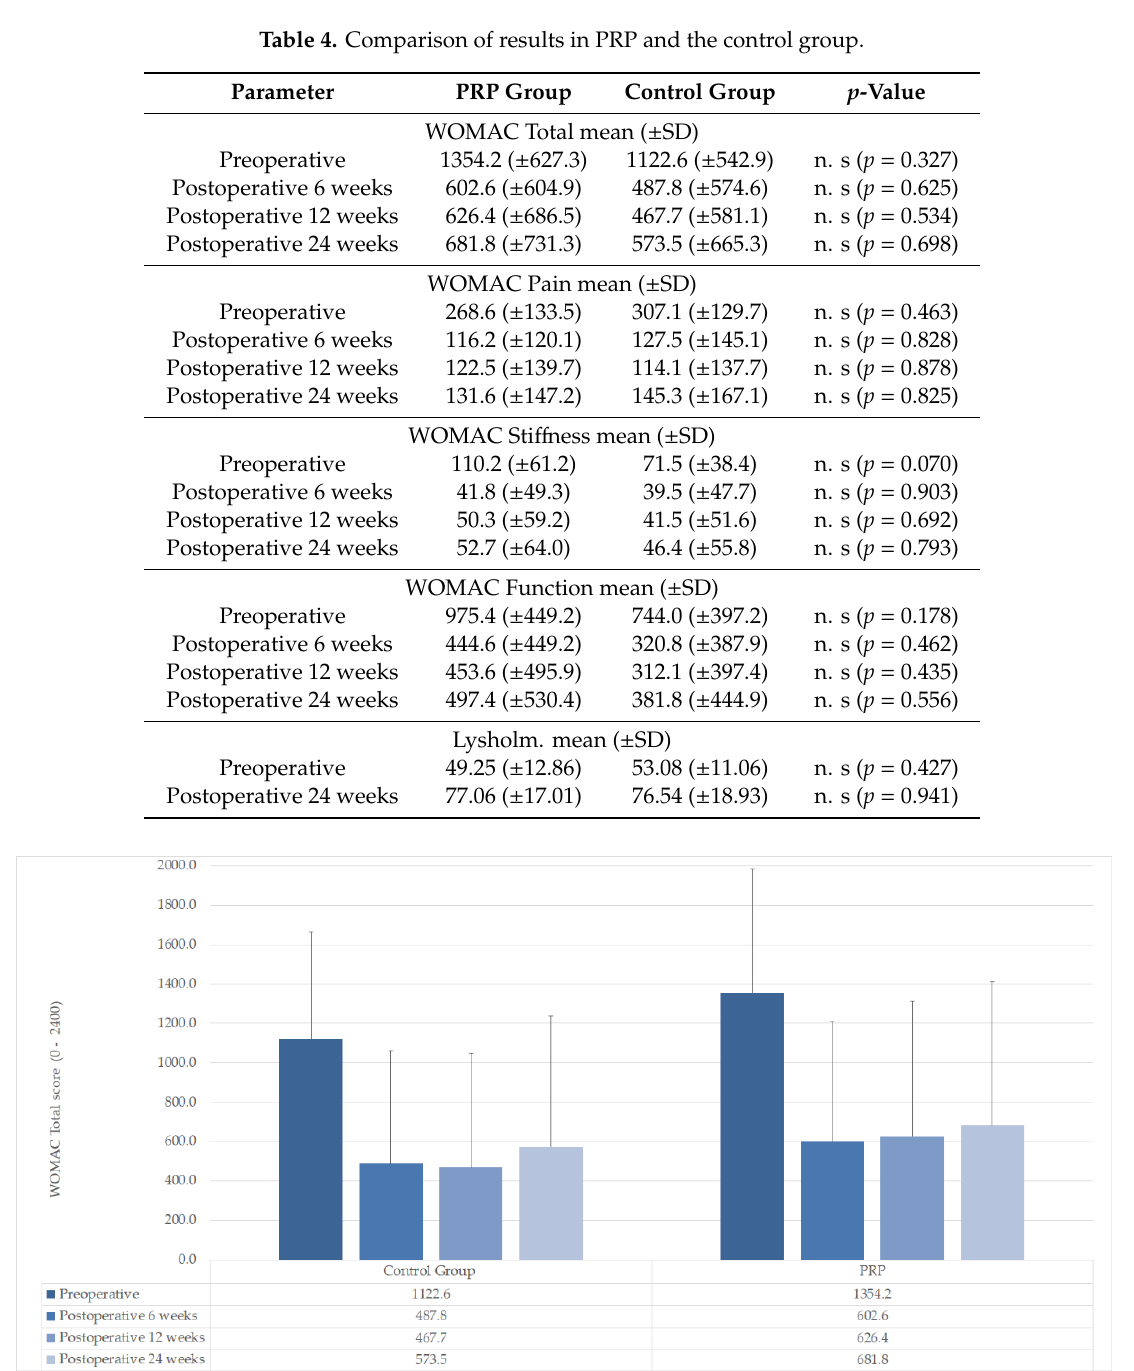
Figure 4. Preoperative vs postoperative stiffness WOMAC scores.